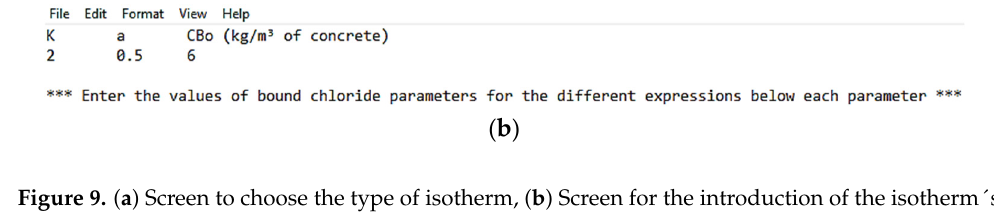
Figure 9. ( a ) Screen to choose the type of isotherm, ( b ) Screen for the introduction of the isotherm´s coefficients.